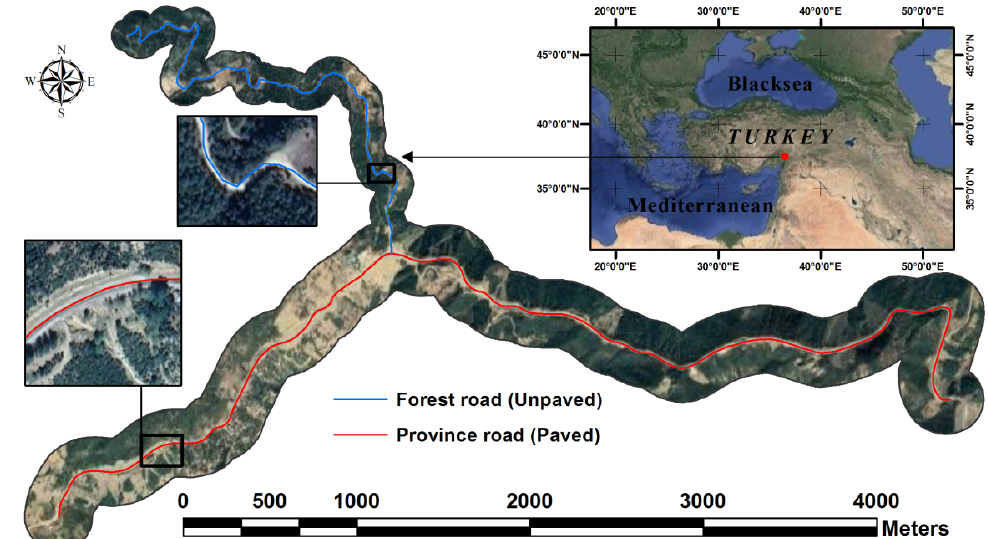
Figure 1. The geographical location of the sample roads and neighboring land use.